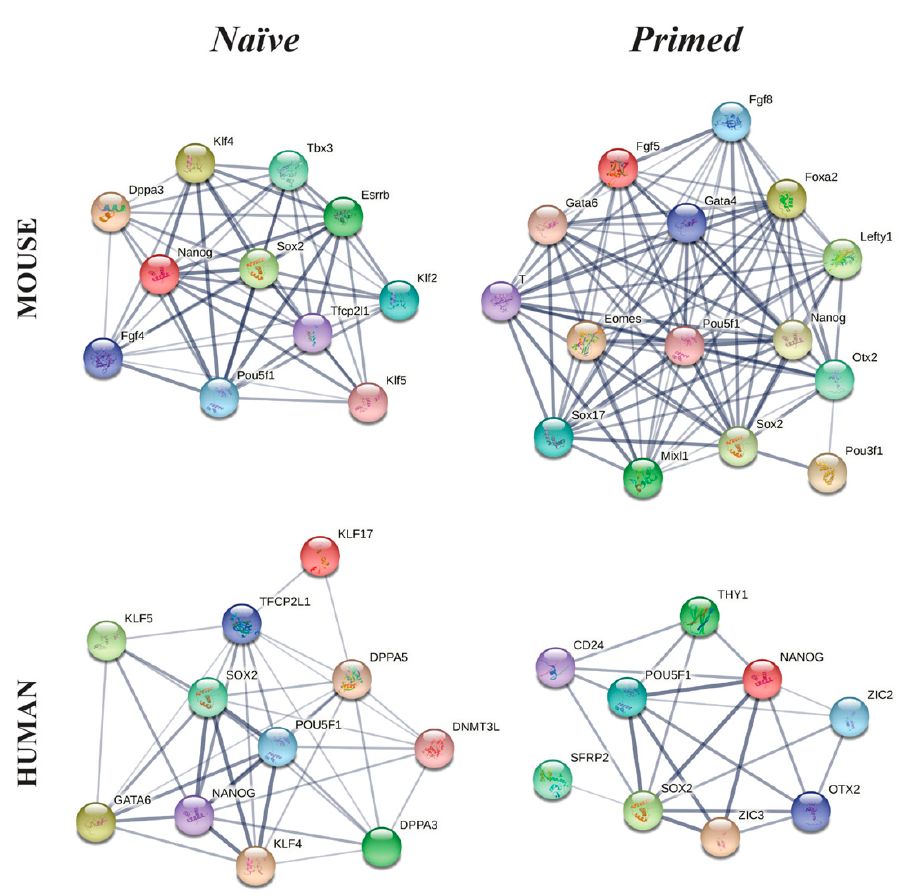
Figure 5. Functional mouse and human protein association networks of the naïve or primed pluripo- tency status, obtained using String (https://string-db.org/ accessed on 1 November 2020). Human